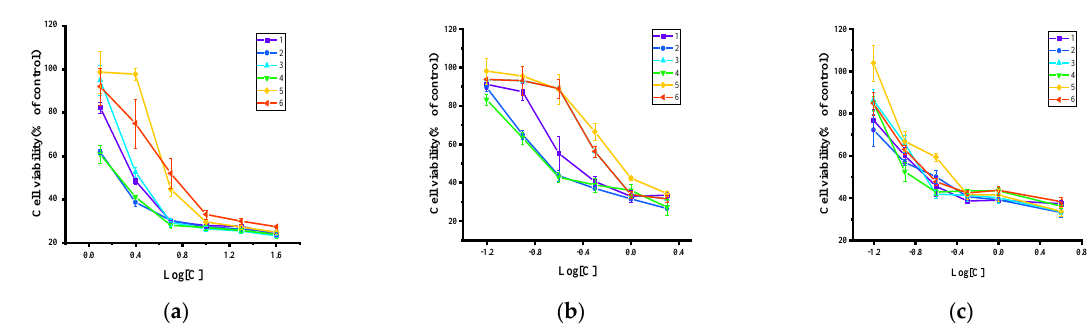
Figure 4. The curves of antitumor activities of compounds 1–6 against ( a ) Eca-109, ( b ) A549 and ( c ) Bel-7402 cell line. Molecules 2020 , 25 , x